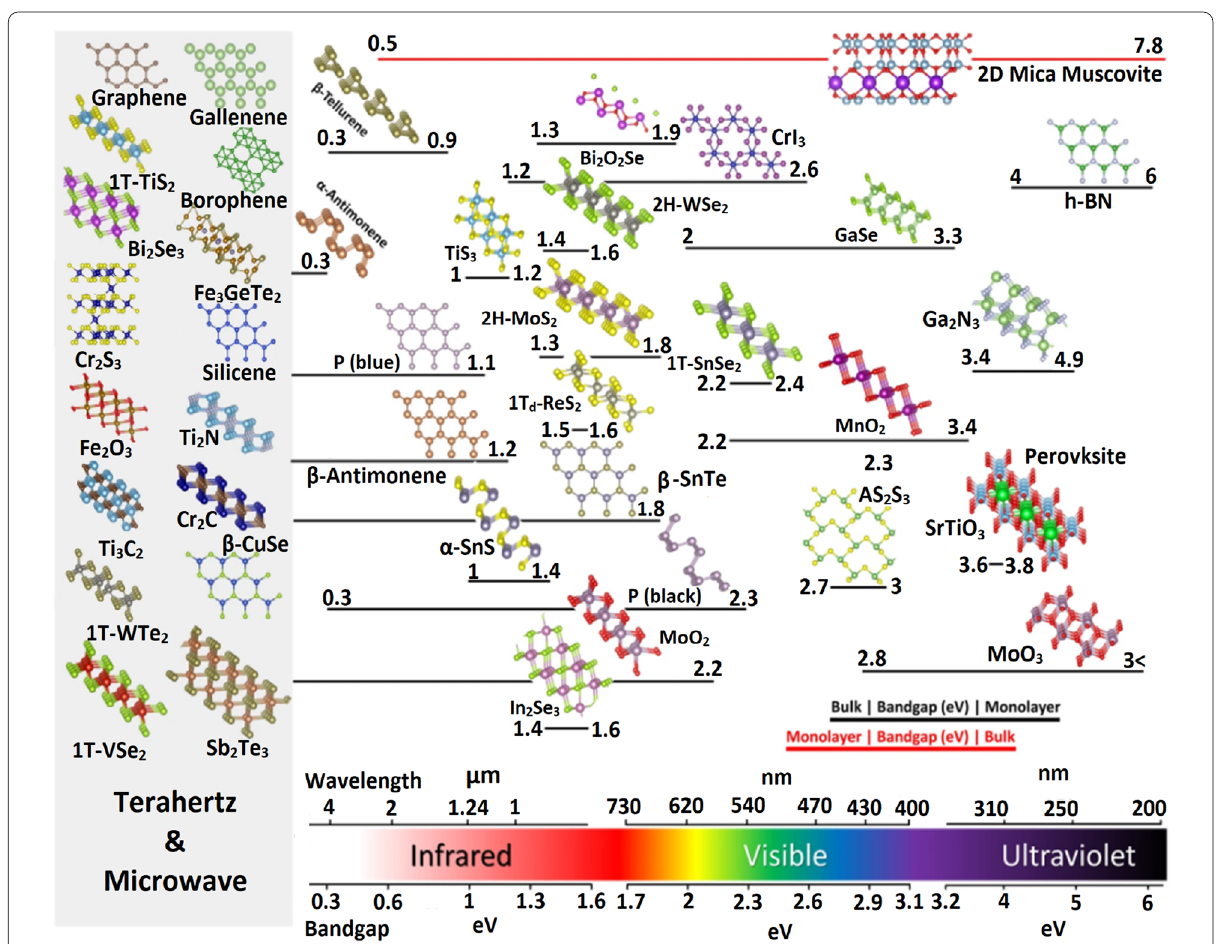
Fig. 1. 2D materials are chosen for their experimental significance and demonstration, with depictions of a perspective view of their crystal structures. The arrangement is following their bandgap, guided by the bottom wavelength/bandgap scale, whereas the bar beneath each structure indicates the bandgap range from bulk to monolayer. Typically, the bulk bandgap is smaller than that of its monolayer (black bars), but there are exceptions (red bars). 2D materials on the far left, indicated by a gray box, are zero or near-zero bandgap, metallic, or semimetallic